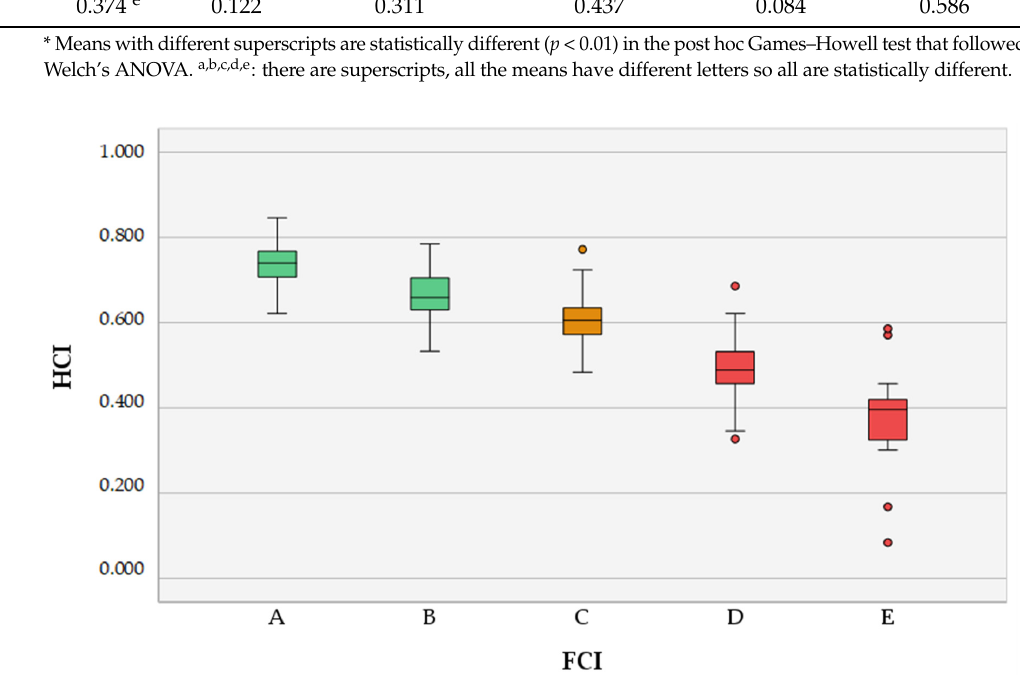
Figure 6. Box-and-whisker plot presenting the Hip Congruency Index classified in F é der á tion Cynologique Internationale categories